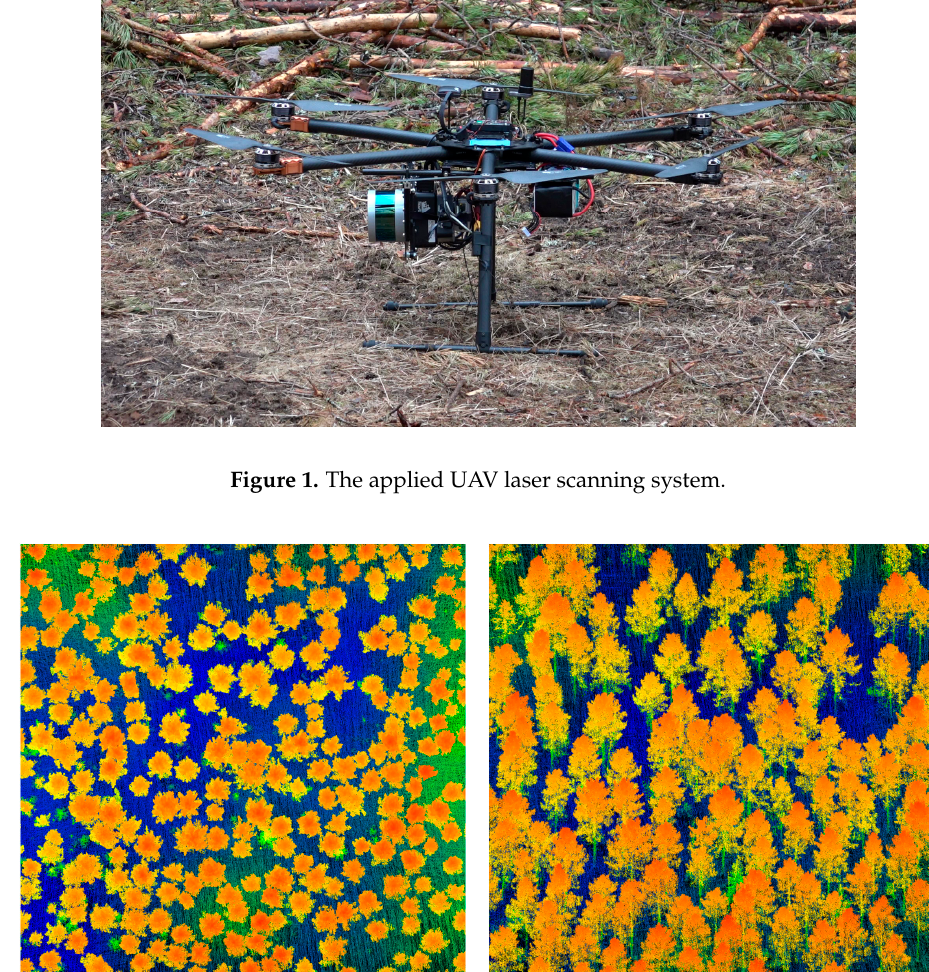
Figure 2. Example scenes of the collected point cloud, colored by elevation; ( left ) bird view; ( right ) isometric view.